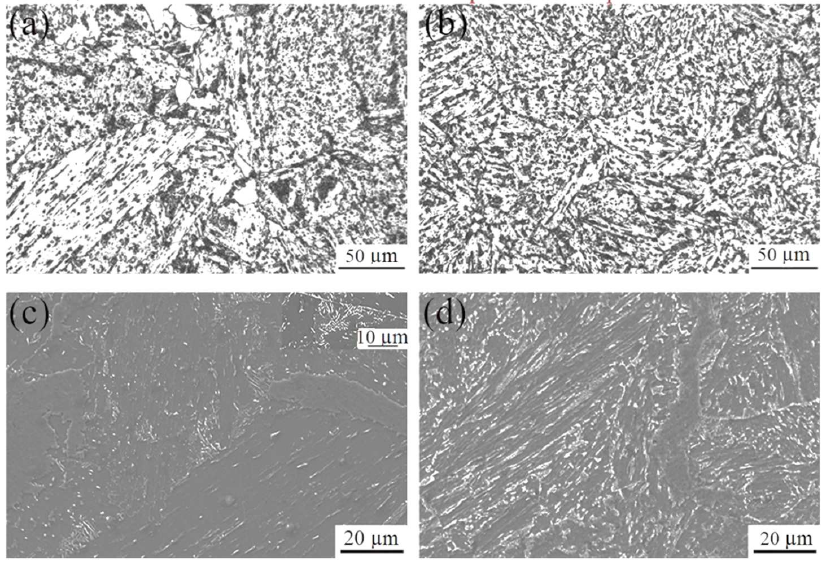
Figure 3. OM and SEM morphology of raw microstructures in rolled and quenched specimens: ( a ) rolled state (OM), ( b ) quenched state (OM), ( c ) rolled state (SEM), and ( d ) quenched state (SEM). Austenite grain growth is a combination of thermal activation, diffusion, and inter- facial reaction. Grain boundary migration is the main manifestation. The comprehensive effect of driving force and grain boundary movement resistance controls the grain growth trend. The higher the temperature of steel is, the greater the atomic diffusion coefficient is, and the carbon atom diffusion coefficient in austenite will also increase, which makes the austenitic nuclei grow faster. At the same time, the interphase free energy difference of the original microstructure increases and the driving force ∆Gv also increases, thus re- ducing the incubation period of austenitic nuclei and the time required for transformation.